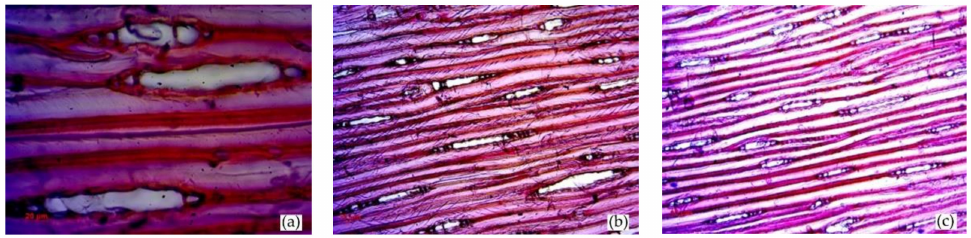
Figure 2. The damage of the ray cells on the tangential surface of the radial and tangential boards ( a ) under high magnification ( × 40), and ( b , c ) under low magnification ( ×